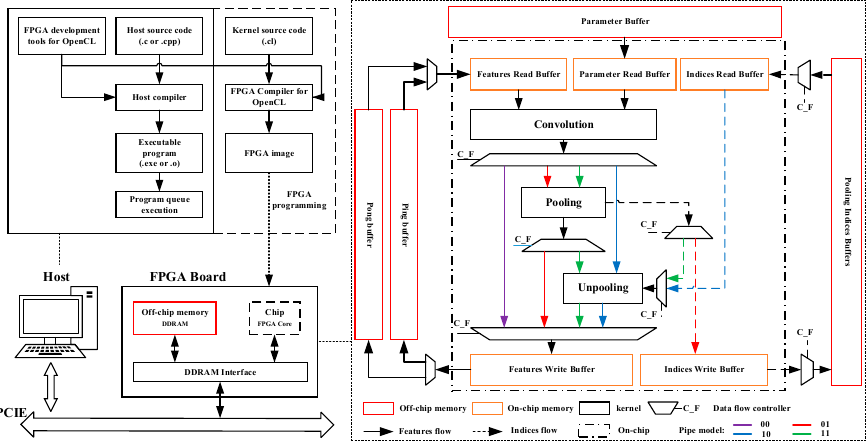
Figure 3. FPGA development process for OpenCL and Encoder-Decoder semantic segmentation networks accelerator (EDSSA) overall architecture.